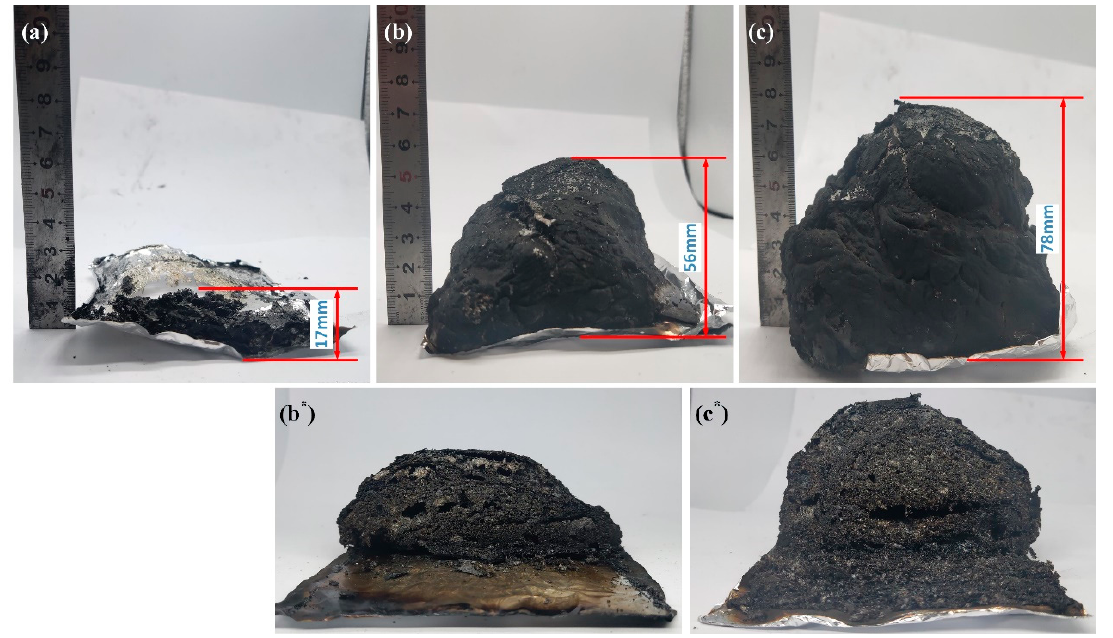
Figure 9. Char morphologies of EP ( a ), EP/15MAPP ( b ), EP/15PPy-MAPP ( c ), profile map of EP/15MAPP ( b * ) and EP/15PPy-MAPP ( c * ). Table 4. Comparison of flame retardant property and smoke suppression performance between EP/15PPy-MAPP and other flame retardant additives in epoxy resin .